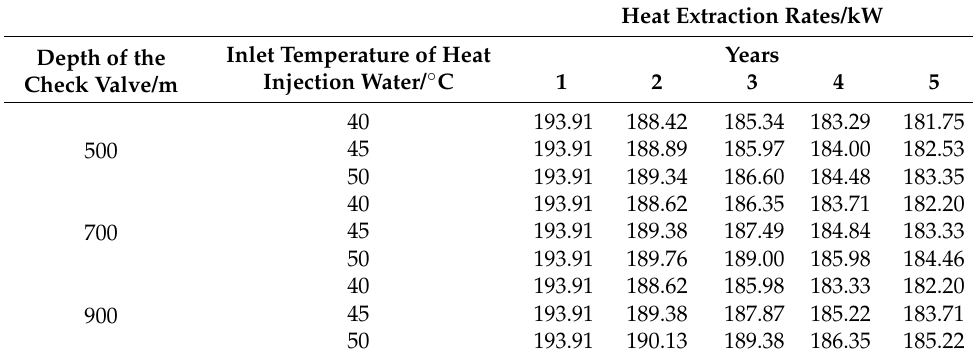
Table 8. Heat extraction rates of different depths of the check